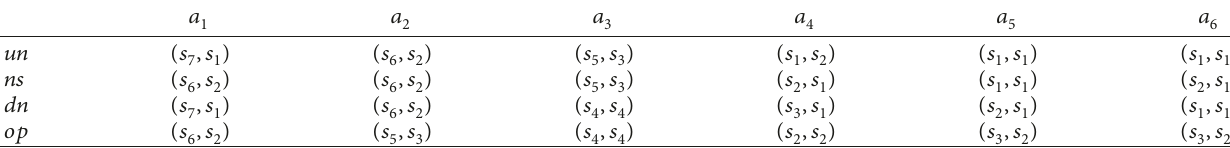
Table 4: Collective decision matrix with LFFWHM